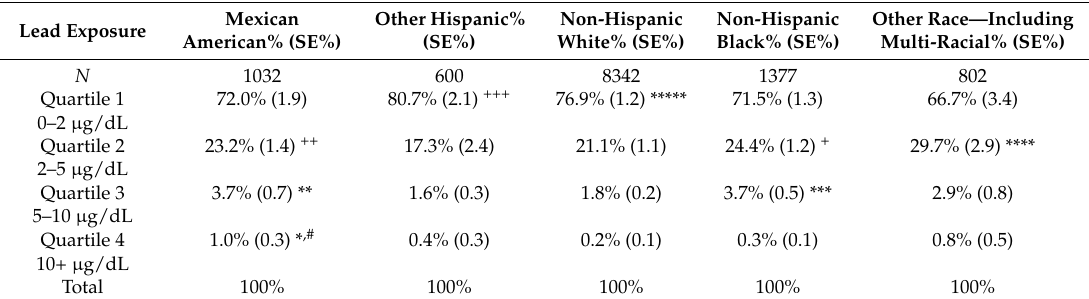
Table 2. Ethnicity and quartiles of